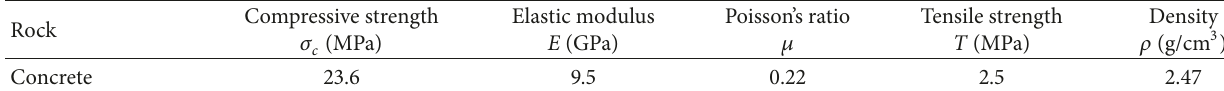
Table 1: Rock properties.